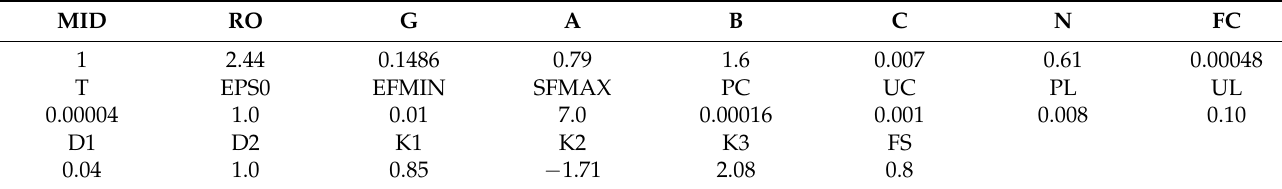
Figure 7. T26 polyurea true stress-strain curve at a high strain rate.